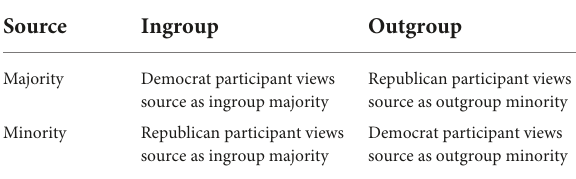
TABLE 1 Source, common group membership, and majority and minority